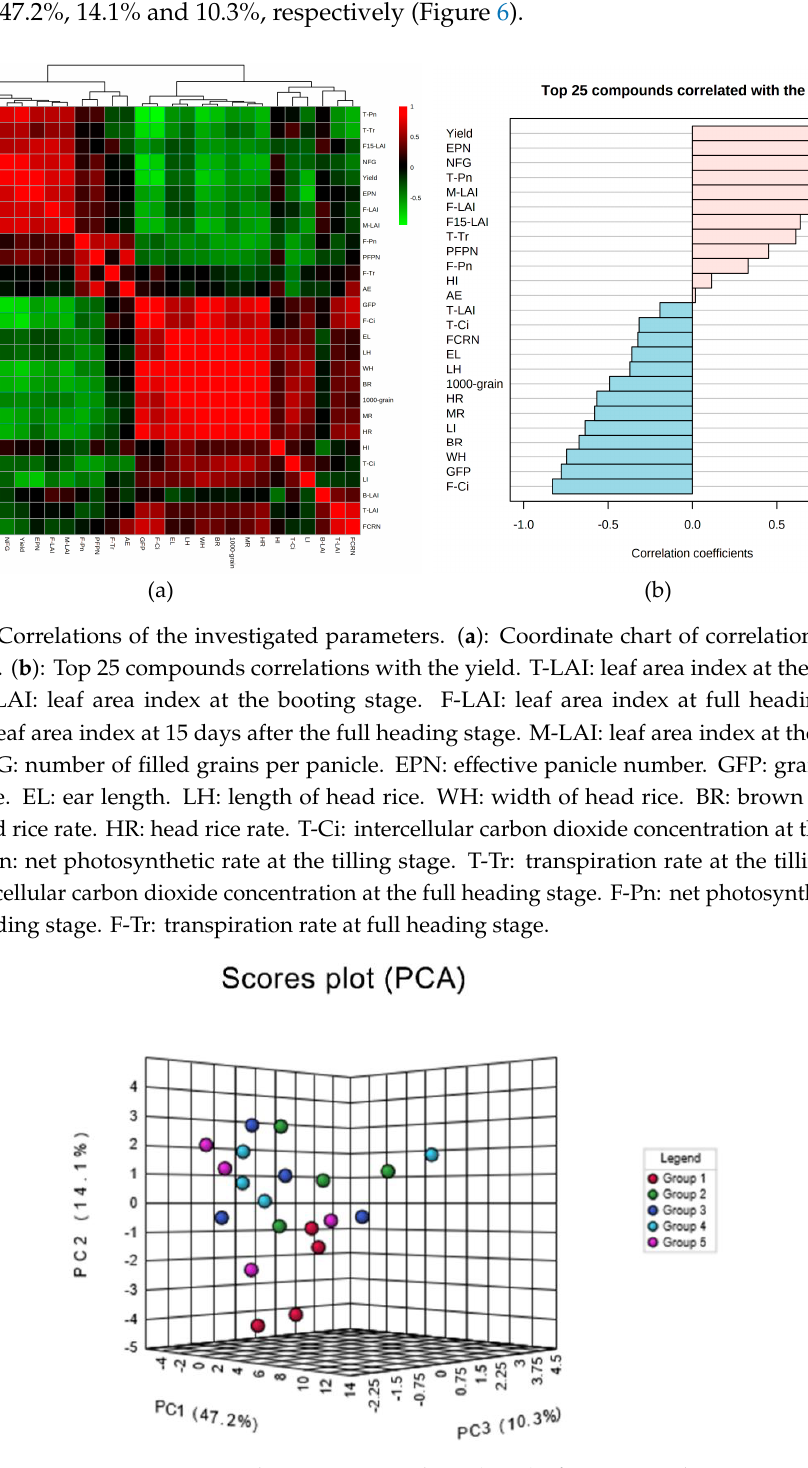
Figure 6. Principal component analyses (PCA) of 3D scores plot.